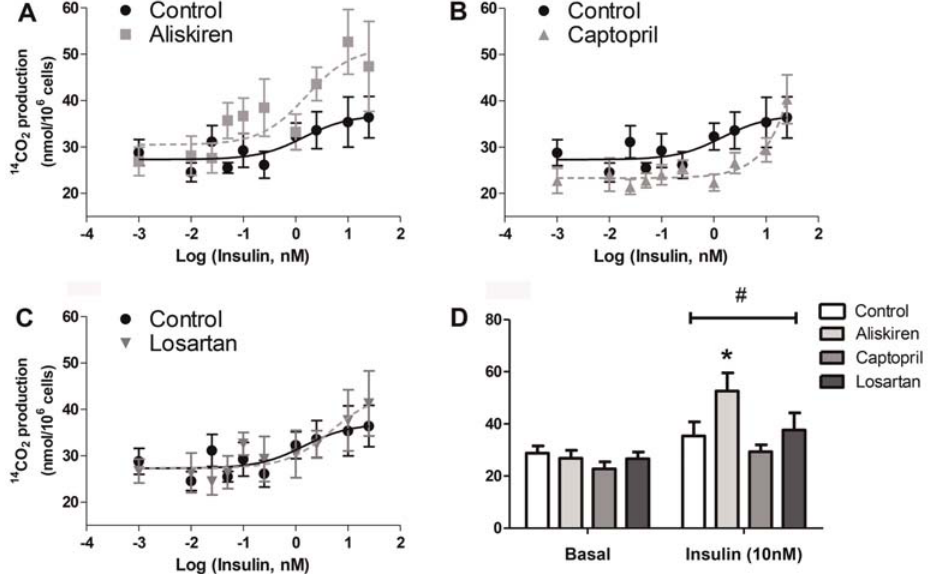
Figure 5. Glucose oxidation of isolated fat cells previously treated with renin-angiotensin system blockers ( A ) aliskiren, ( B ) captopril and ( C ) losartan were incubated with increasing concentrations of insulin for 60 min at 37°C. D-[U- 14 C]-glucose (0.05 m Ci/tube) was added to the incubation medium at the beginning of the test. At the end, 14 CO 2 was collected, and the radioactivity was determined. D , basal and 10 nM insulin-stimulated oxidation. *P o 0.05 aliskiren vs control in 10 nM insulin-stimulated state. There was also signi fi cant insulin glucose oxidation stimulus ( # P o 0.001 for basal vs 10 nM insulin). Data are reported as the mean ± SE (n=6). Two-way ANOVA and the Bonferroni ’ s post hoc tests were